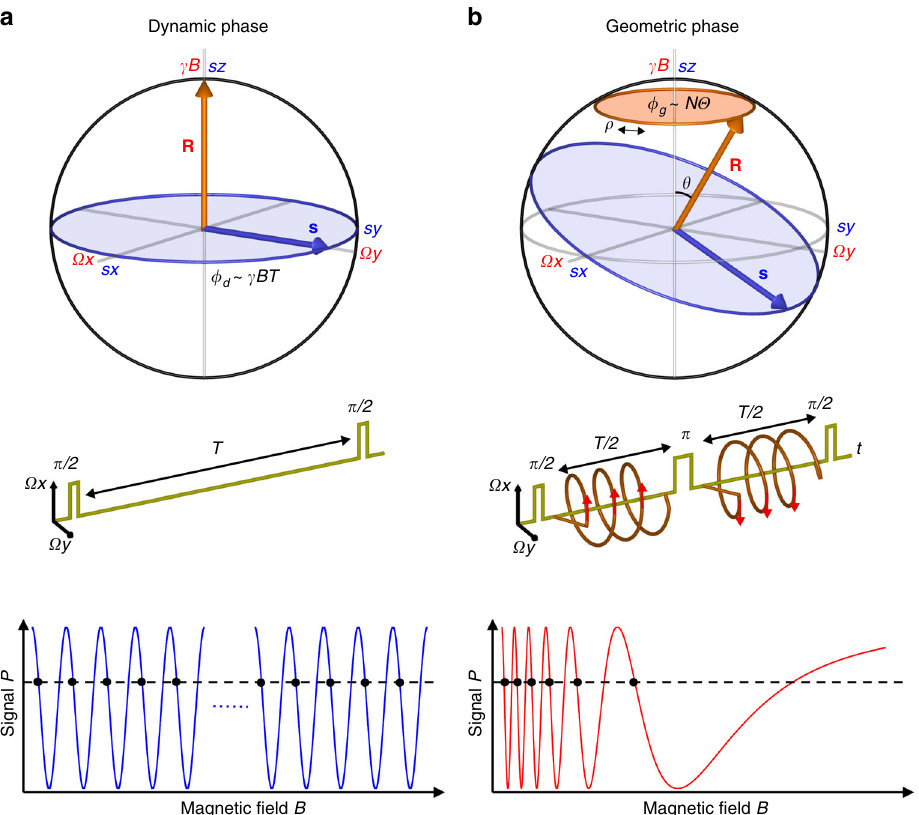
Fig. 1 Concepts of dynamic- and geometric-phase magnetometry. a For dynamic-phase magnetometry with an NV spin, the Bloch vector s = ( s x , s y , s z ) (blue arrow), initially prepared by a π /2 pulse in a superposition state between two levels, precesses about the fi xed Larmor vector R = (0, 0, γ B ) (red arrow). During the interaction time T between the two π /2 pulses, the spin coherence accumulates a dynamic phase ϕ d = γ BT , equivalent to the angle swept by the Bloch vector on the equator. The phase is then mapped by a second π /2 pulse to a population difference signal P = cos ϕ d , which is measured optically. Due to a 2 π phase periodicity, an in fi nite number of magnetic fi eld values (black dots) give the same signal, leading to an ambiguity. b For geometric-phase magnetometry with an NV spin, a Berry sequence is employed. The Bloch vector is fi rst prepared by a π /2 pulse in a superposition state between two levels. An additional off-resonant driving is then used to rotate the Larmor vector about the z -axis N times, R ( t ) = ( Ω cos ρ ( t ), Ω sin ρ ( t ), γ B ), where ρ ( t ) = 4 π Nt / T . The spin coherence acquires a geometric phase ϕ g = N Θ , proportional to the number of rotations N and the solid angle Θ = 2 π (1 − cos θ ) subtended by the trajectory of the Larmor vector. To cancel the dynamic phase and double the geometric phase, the direction of rotation is alternated before and after a π pulse at the midpoint of the interaction time. At the end of the Berry sequence, the phase is mapped by a second π /2 pulse to a population difference signal P = cos ϕ g , which is measured optically. The signal exhibits chirped oscillation with magnetic fi eld amplitude, which yields at most fi nite magnetic fi eld degeneracies (black dots). The signal vs. fi eld slope resolves this